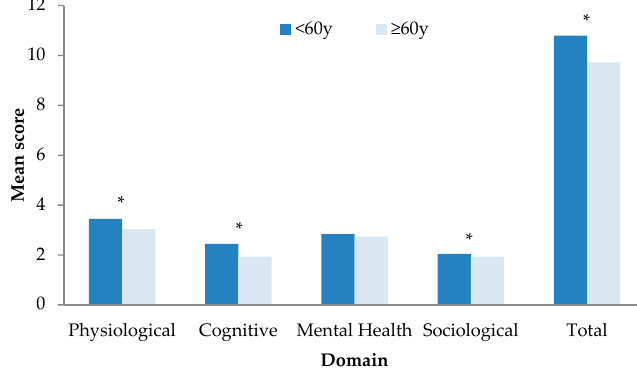
Figure 1. Mean domain and total scores by age group (under 60 years, 60 years and over). Significant differences between age groups are denoted in the figure with an asterisk (*) at p <